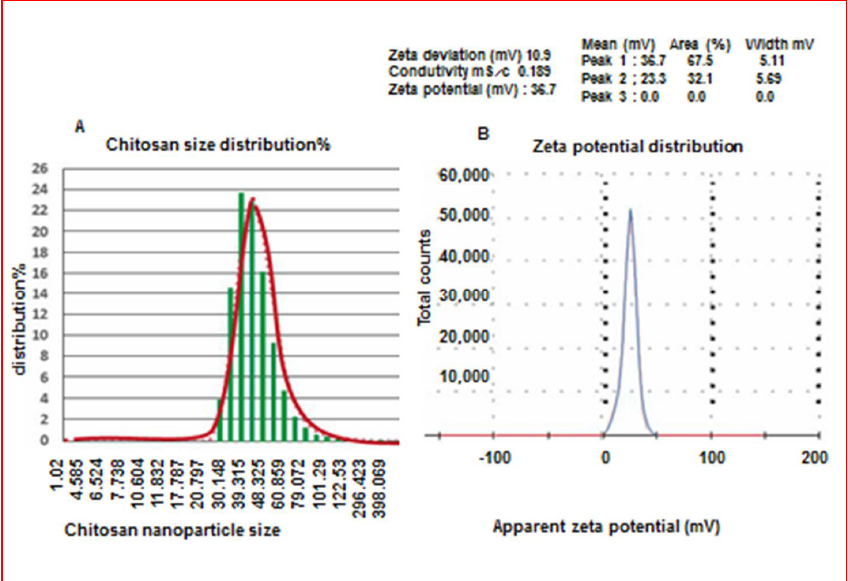
Figure 3. Characterization of physic chemical synthesized chitosan nanoparticles (CS-NPs). A: chitosan particle size distribution histogram with average size of 34.39 nm. B: Zeta potential charge measurement revealed a positive surface charge with 25.9 mV.